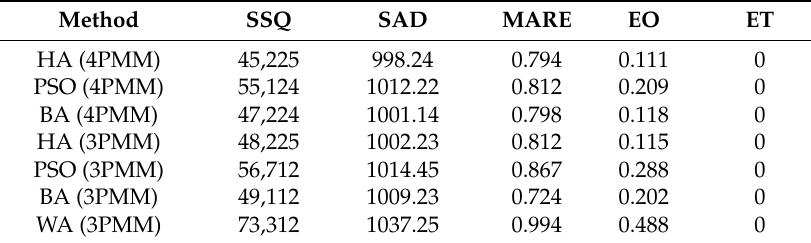
Table 15. Evaluation of different methods for Viessman and Lewis flood.